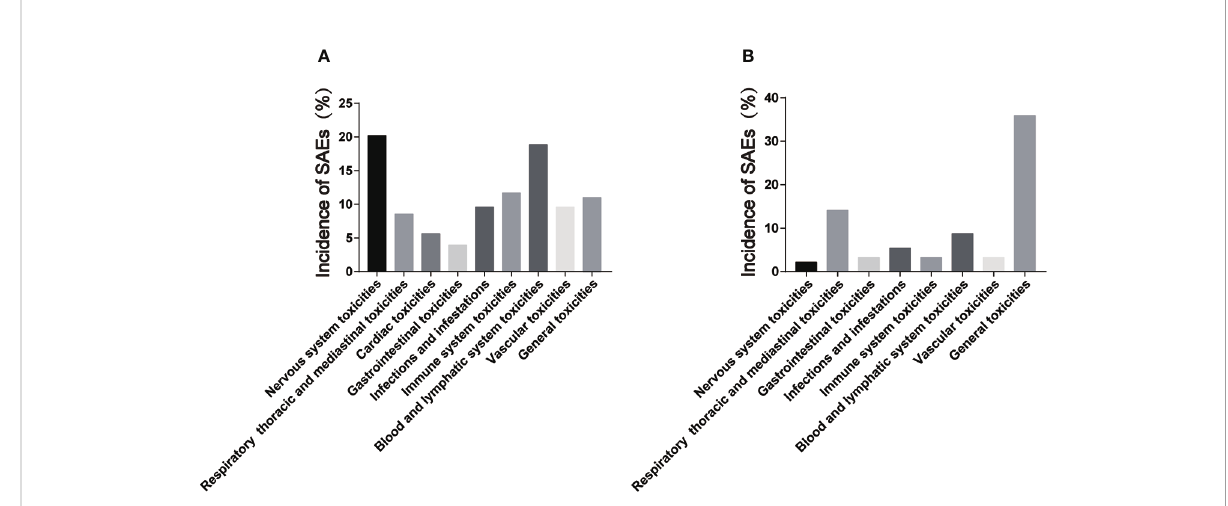
FIGURE 2 Incidence of serious adverse events of CAR-T cells in hematological and solid tumors. (A) is the incidence of serious adverse events of hematological tumors; (B) is the incidence of serious adverse events in solid